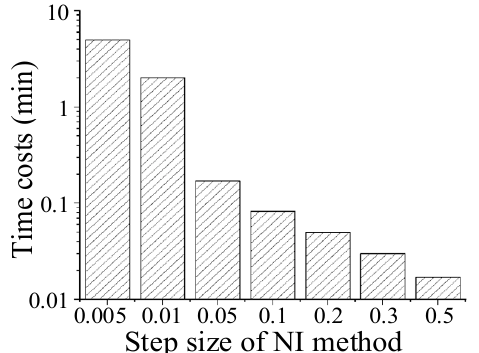
Figure 9 . Time costs of cases applying the NI method.